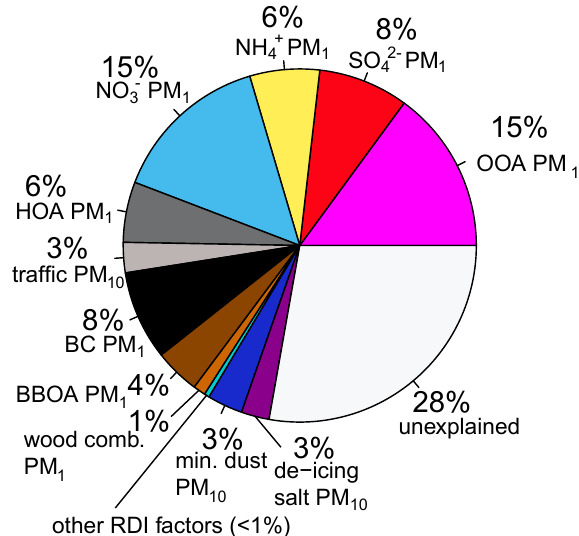
Fig. 14. Contributions of all identified sources with RDI- and AMS- PMF plus inorganic compounds measured with the AMS as well as BC (PM 1 ) to total PM 10 mass for the interval of simultaneous RDI, AMS and BC measurements. The secondary sulfate factor found with RDI-PMF is omitted to avoid double counting with SO 2 −